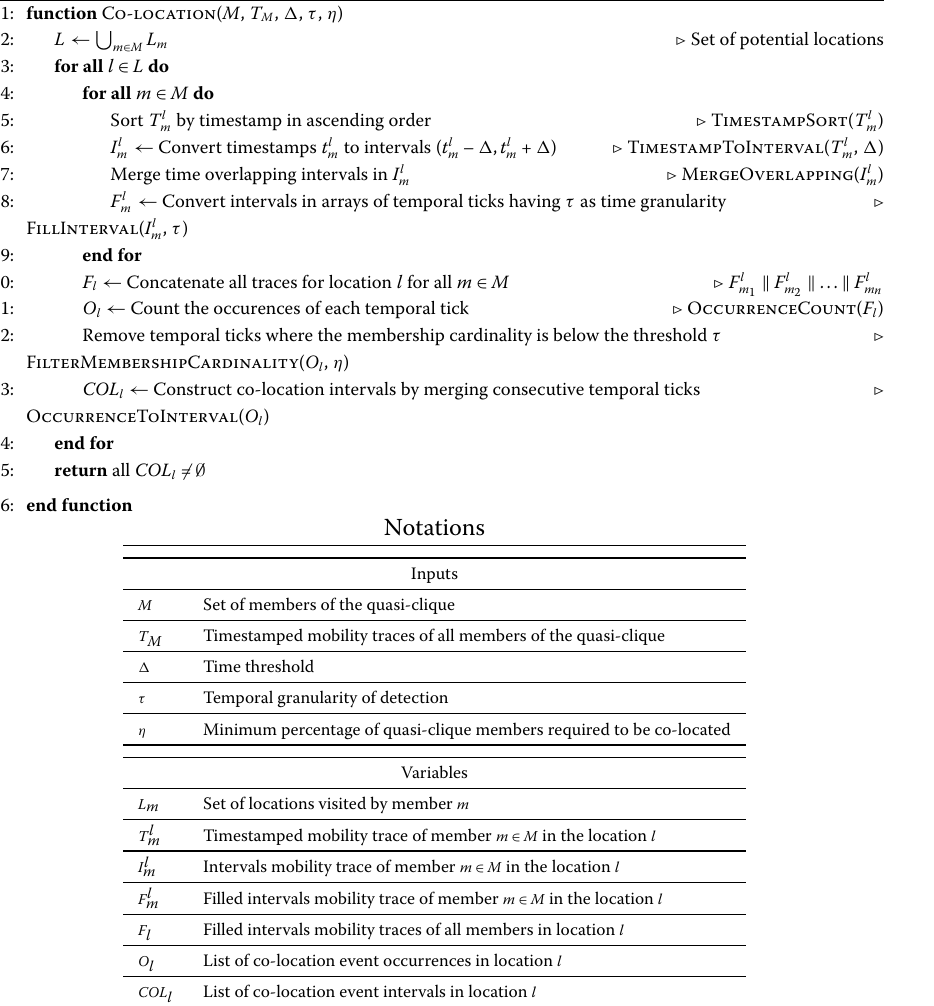
Algorithm 1 Quasi-clique